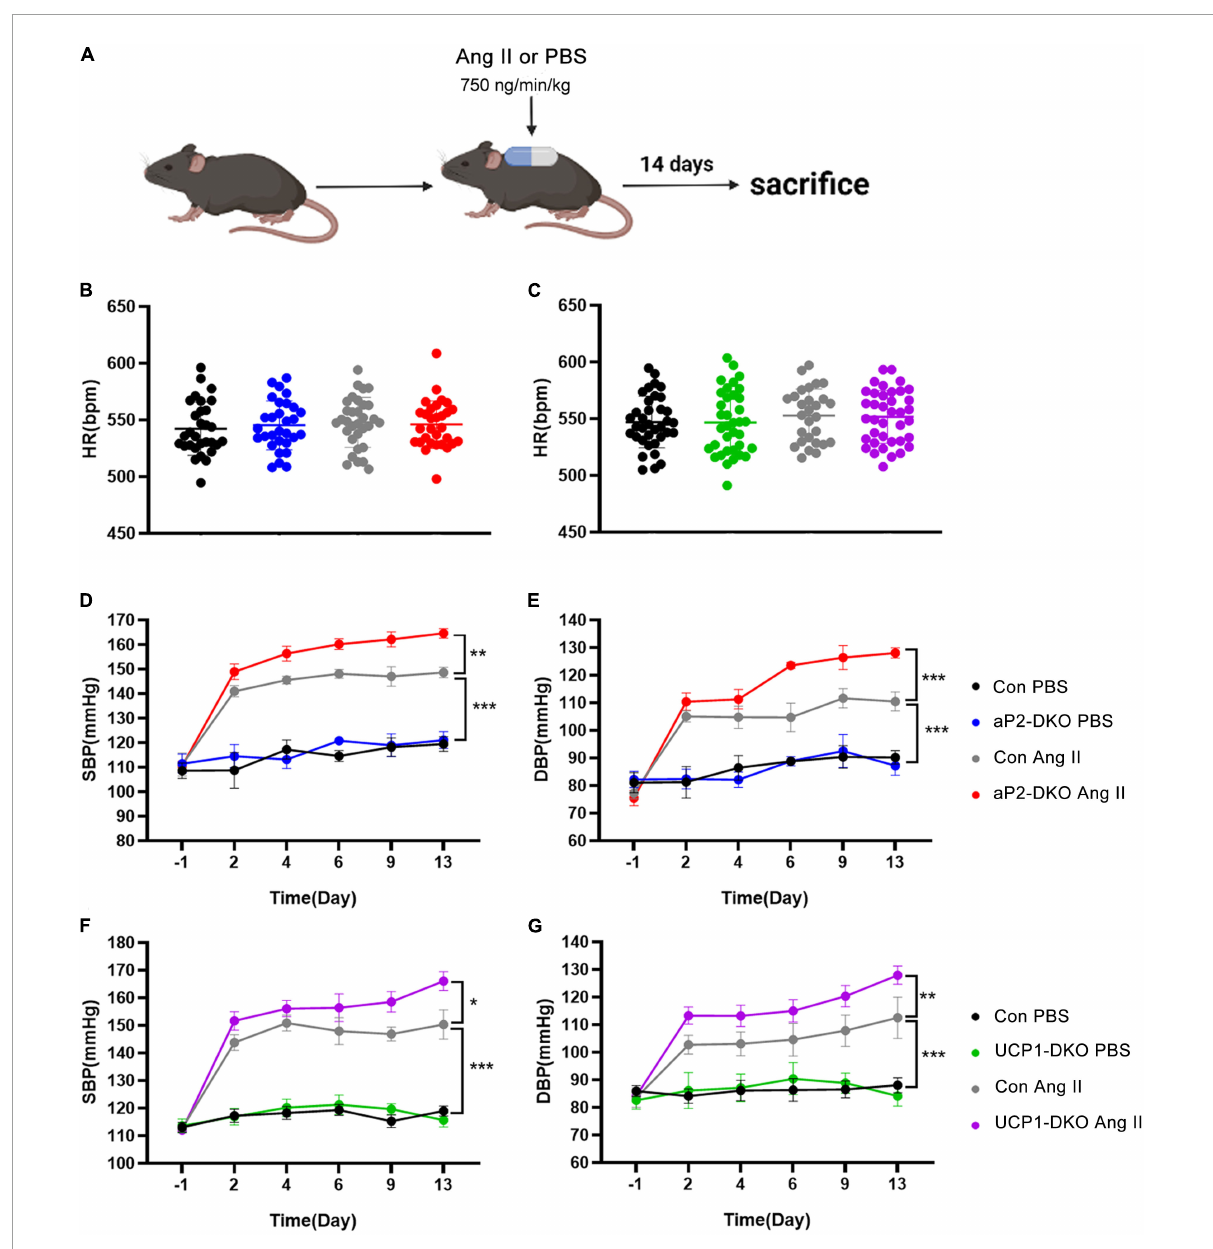
FIGURE2 Deficiency of bone morphogenetic protein 4 (BMP4) in perivascular adipose tissue (PVAT) aggravates Angiotensin II-induced hypertension. (A) Animal models of Ang II (angiotensin II)-induced hypertension. (B) Heart rate of the control and aP2-DKO mice before and after Ang II/PBS administration. (C) Heart rate of the control and UCP1-DKO mice before and after Ang II/PBS administration. (D) Average SBP and (E) DBP of the control and aP2-DKO mice before and after Ang II/PBS administration. (F) Average SBP and (G) DBP of the control and UCP1-DKO mice before and after Ang II/PBS administration. Values are means ± S.E.M. * P < 0.05, ** P < 0.01, and *** P < 0.001 by one-way analysis of variance (ANOVA) (B,C) or two-way analysis of variance (ANOVA) (D–G)